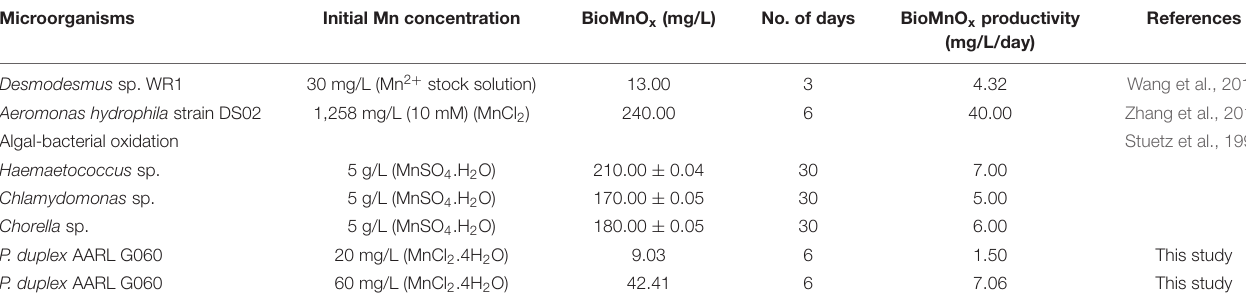
TABLE 2 | BioMnO x productivity of Pediastrum duplex AARL G060 compared with previous studies.